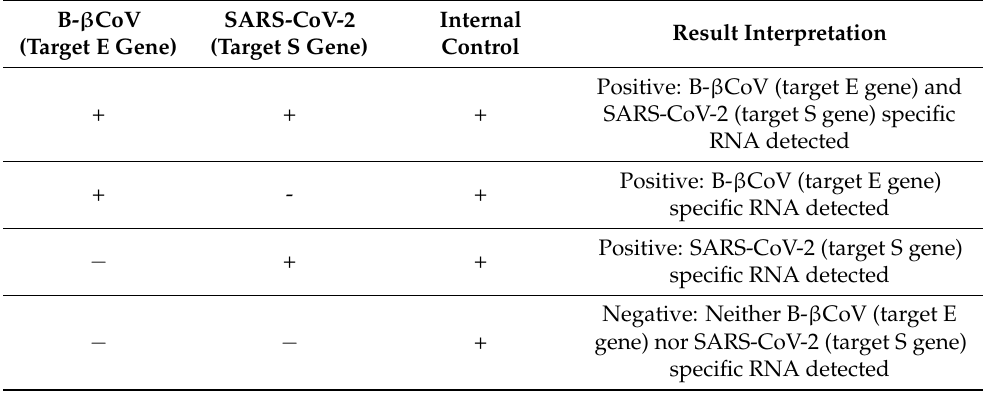
Table 2. Qualitative analysis for SARS-CoV-2 RNA